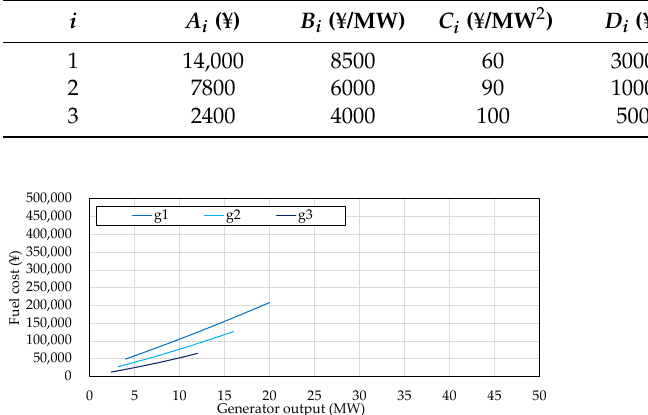
Figure 2. Fuel cost functions of each CG (“¥” means “any currency unit is applicable”).